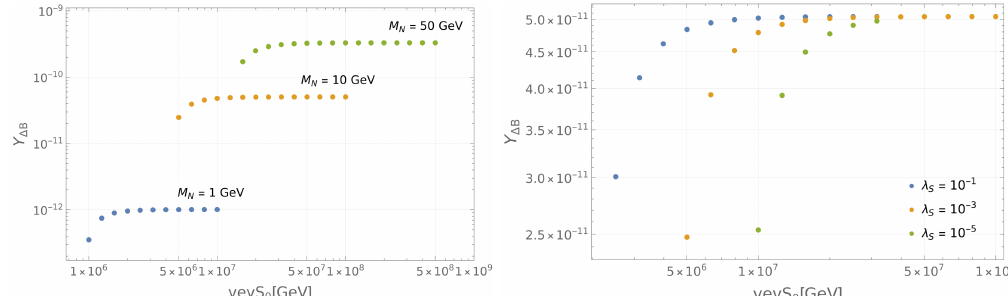
Figure 4. Baryon asymmetry production as a function of the S vacuum expectation value v 0 Left: the three lines correspond to fixed sterile neutrino masses M 0 coupling has been fixed to λ S = 10 − 3 . Right: the three lines correspond to S self couplings λ S = 10 − 5 , 10 − 3 , 10 − 1 . The sterile-neutrino mass has been fixed to M 0 λ SH = 10 − 3 has been